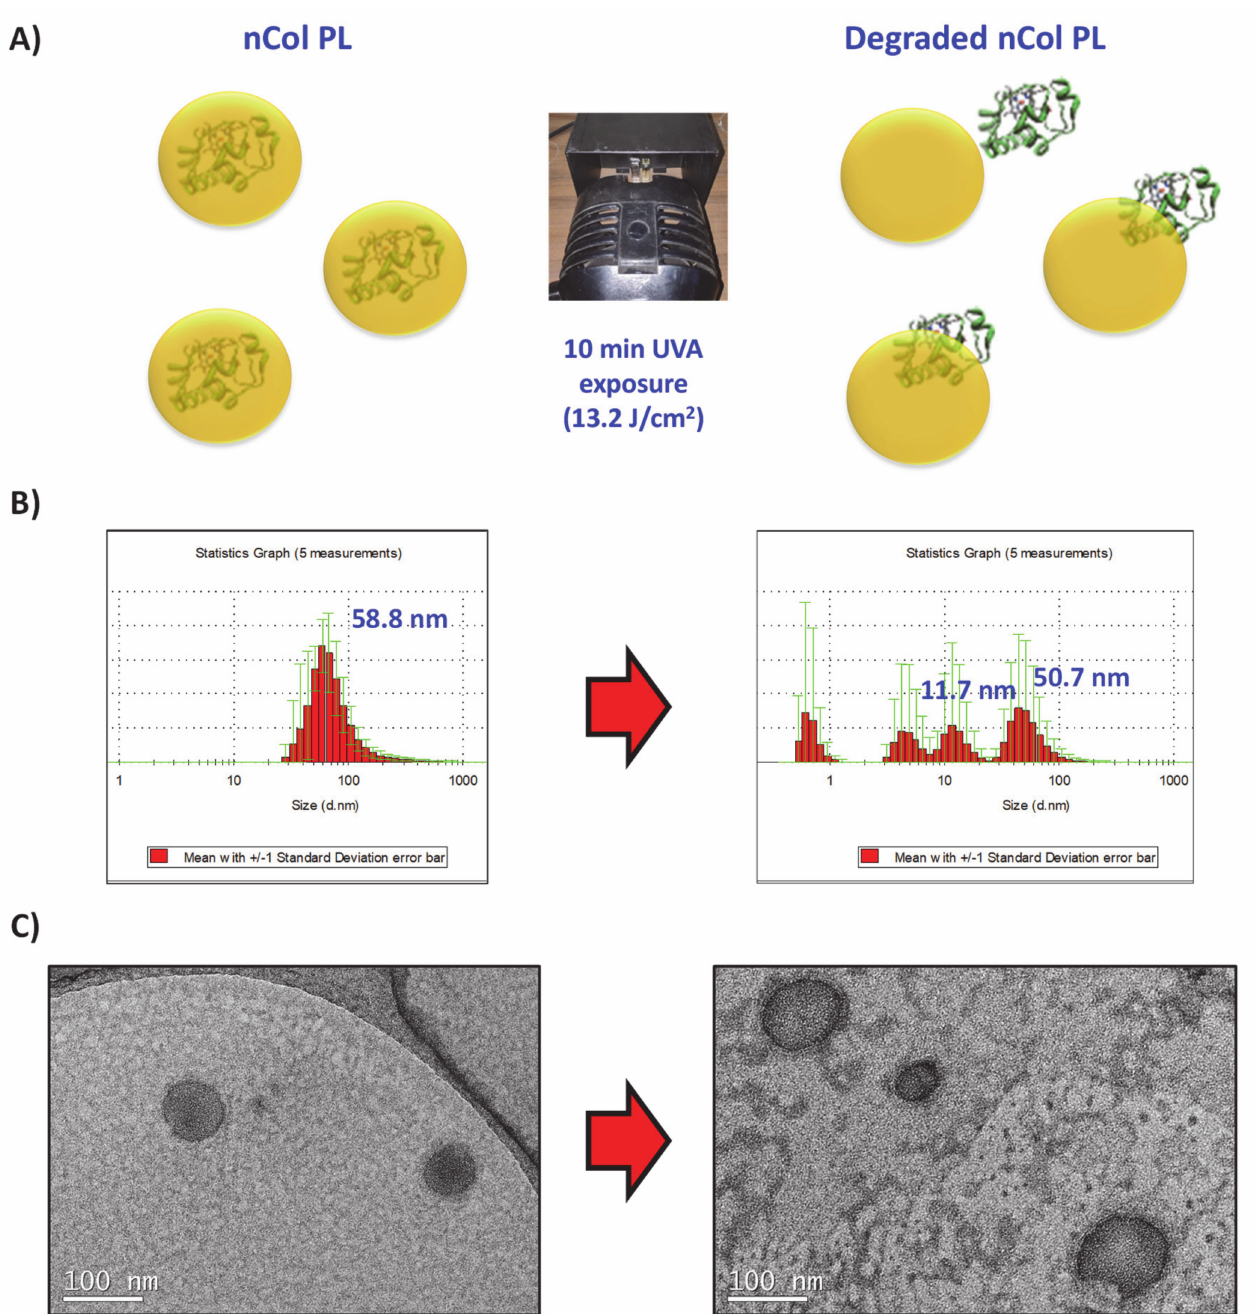
Figure 4. ( A ) UVA-sensitive nanocapsules exposed 10 min to UVA irradiation. ( B ) DLS analysis showed initial 58 nm size of nanocapusules (Left side), which after irradiation showed several size distributions that correspond with col- lagenase nanocapsules and free collagenase (Right side). ( C ) TEM micrographs also signaled the breakage of the nanocapsule